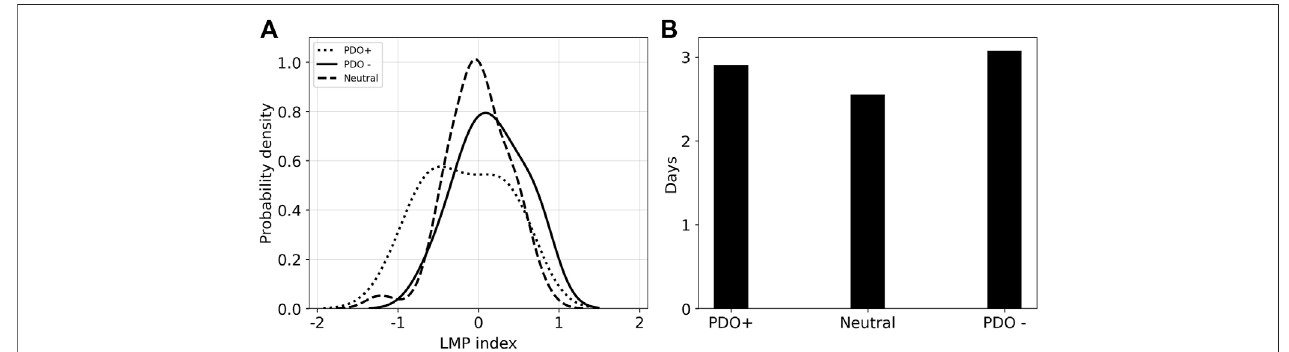
FIGURE 8 | (A) PDF of LMP indices and (B) the relative frequency of extreme precipitation during different phases of the PDO.